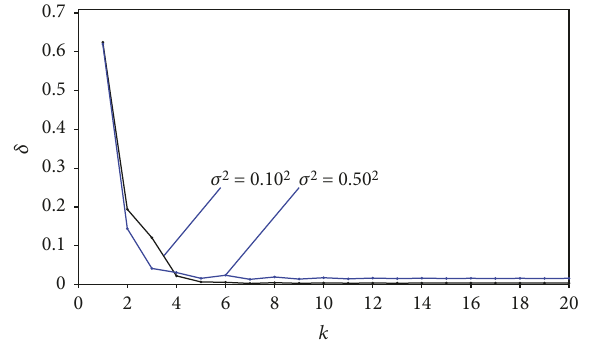
휎 2 = 0.10 2 휎 2 = 0.50 2